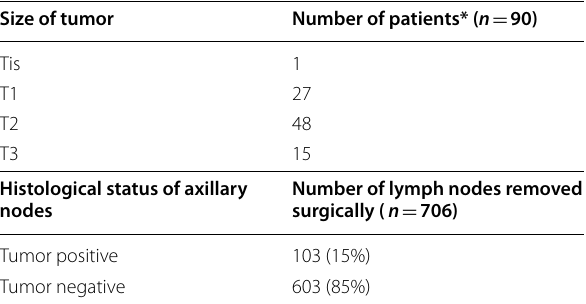
Table 3 Tumor size and histological status of removed lymph nodes